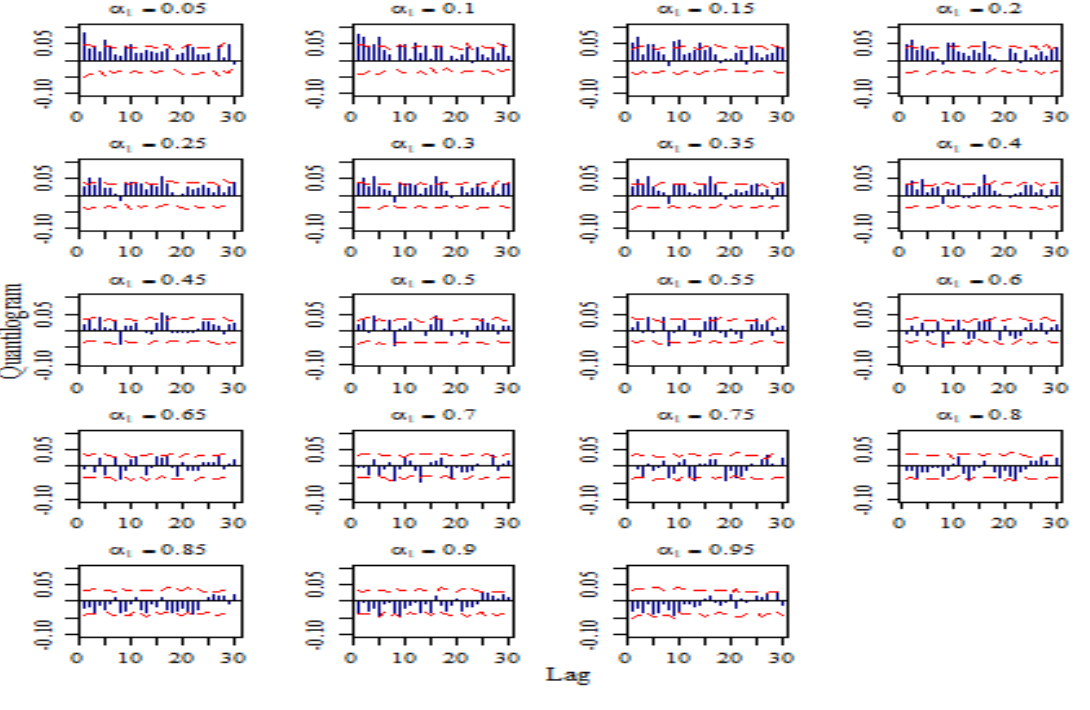
Figure 7. Sample cross-quantilograms for WTI returns in the lower quantile, i.e., q 2 ( α 2 ) for α 2 = 0.1, to capture directional predictability from WTI return to OVX. See notes to Figure 3.